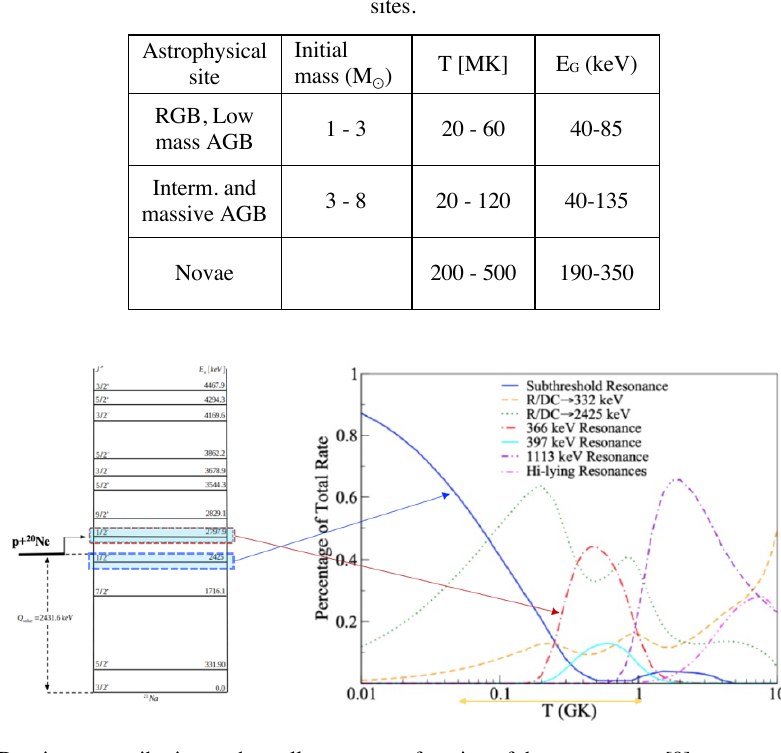
Fig. 1. Dominant contribution to the stellar rates as a function of the temperature [9].